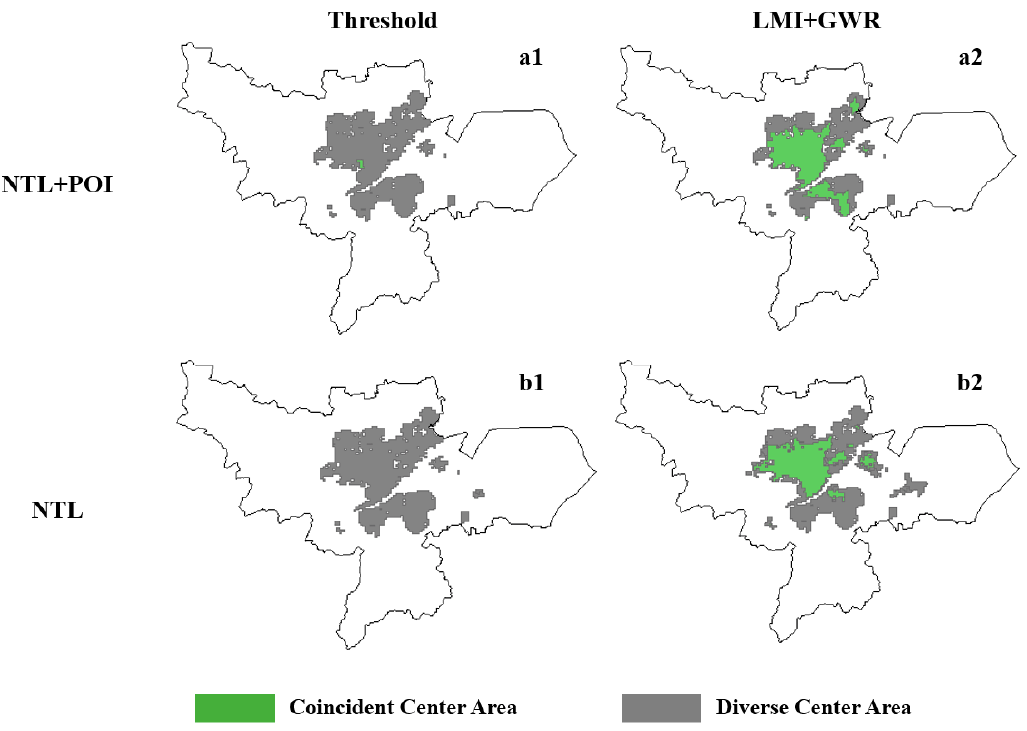
Figure 13. Centers areas intersect results. The overlapped center areas were shown in green and the different center areas were shown in gray .